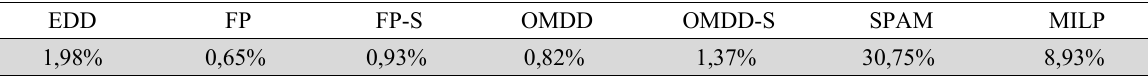
Fig. 6. Large-sized test instances: boxplot for average 𝑅𝐷𝐼 values depending on 𝑅𝐷𝐷